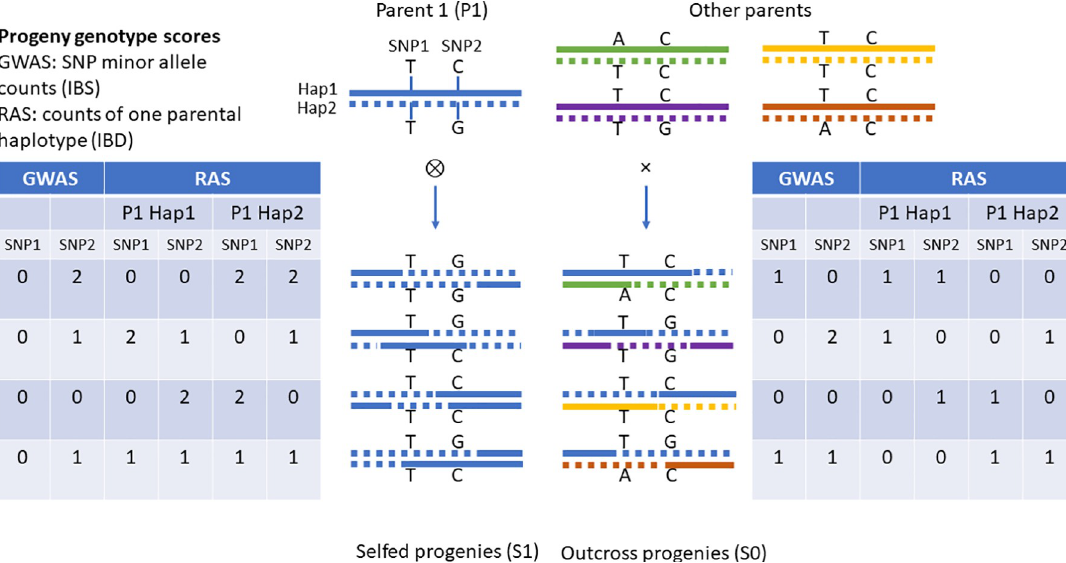
Fig 1. Diagram of key features of rare allele linkage scan compared to genome wide association study tests for quantitative trait loci.